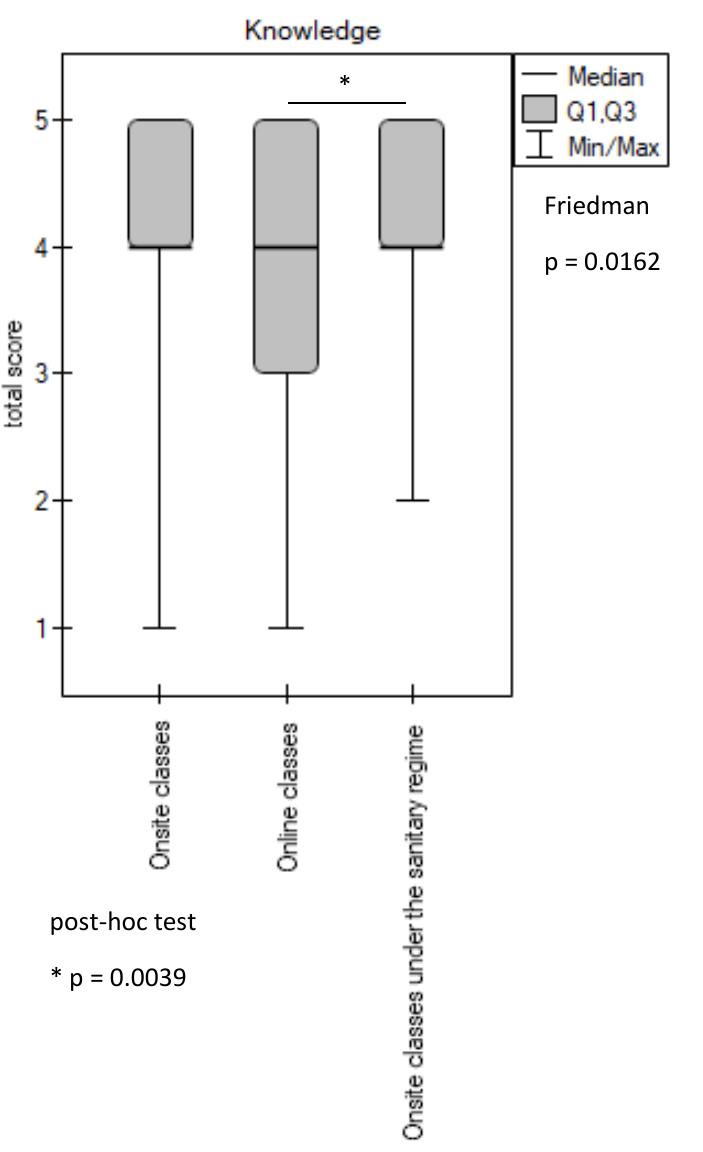
Figure 1. Evaluation of the achieved learning outcomes in the scope of knowledge. * p -value is given for statistically significantly different groups. For groups with no significant differences ( p ≥ 0.05), the p -values are not quoted.